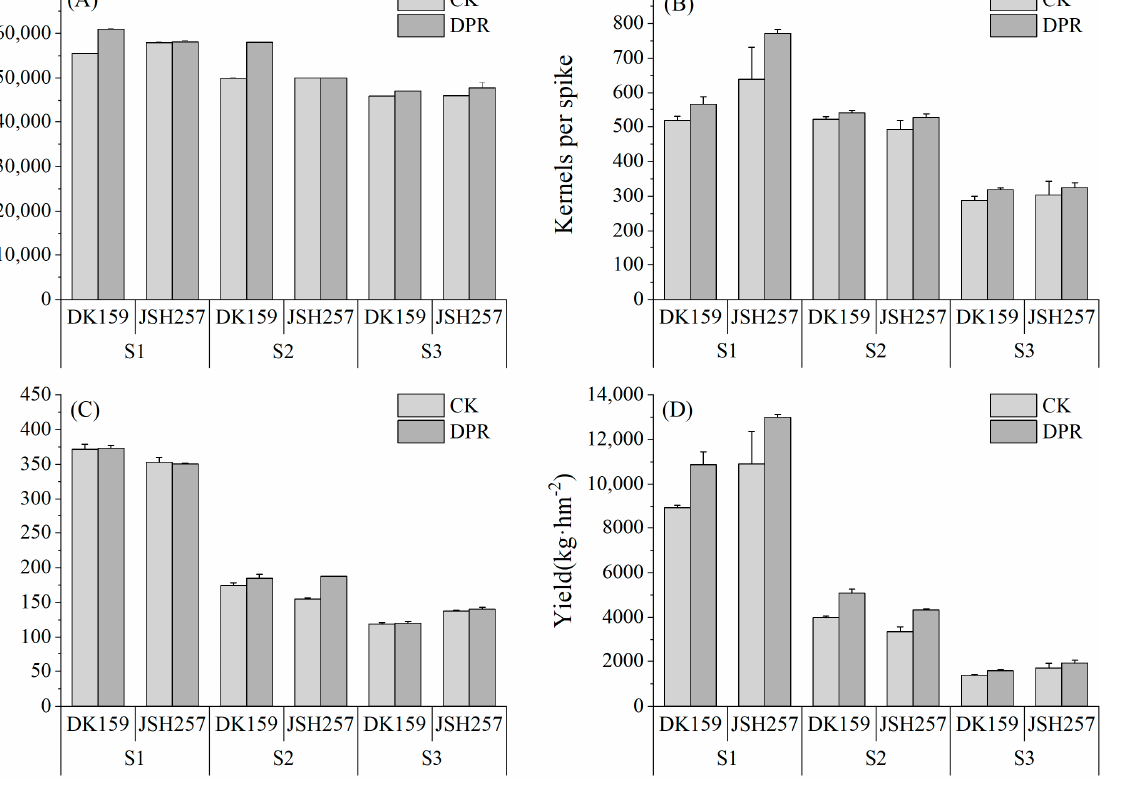
Figure 3. Effects of deep straw return on maize yield and its constituents in saline land. ( A , B ), and ( C ) represent the components of maize yield, and ( D ) represents maize yield. CK is shallow rotation, and DPR is deep straw return treatment.